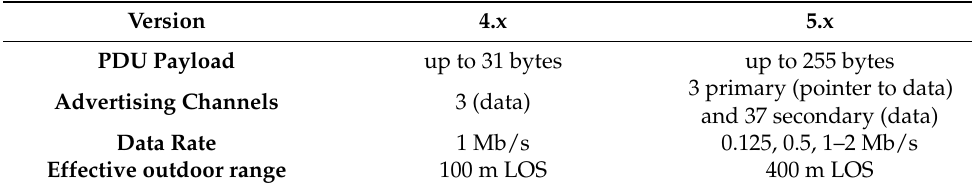
Table 1. Main features of the different BLE versions.